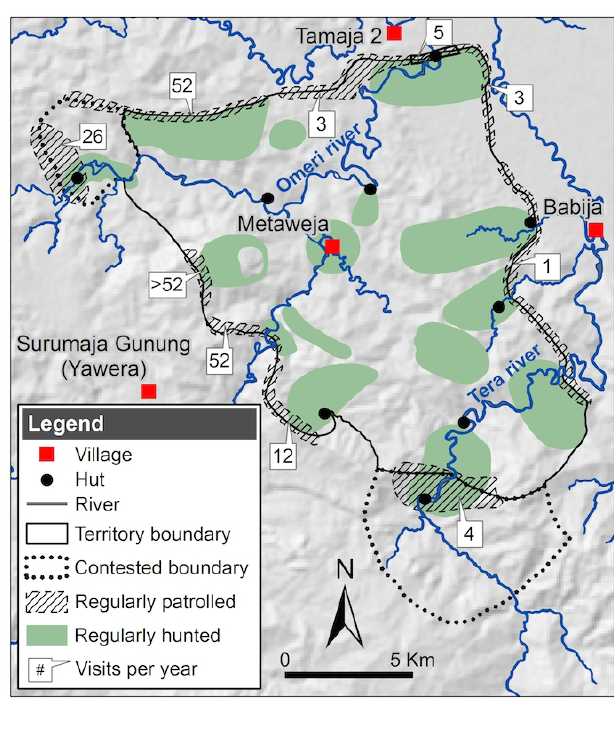
Fig. 6 . Map of Metaweja territory showing areas regularly visited for hunting and highlighting the relative frequency per year of boundary visits, based on scoring by the hunters involved (Metaweja men). Rivers and relief are based on terrain data, but boundaries and areas visited are based on hand- drawn